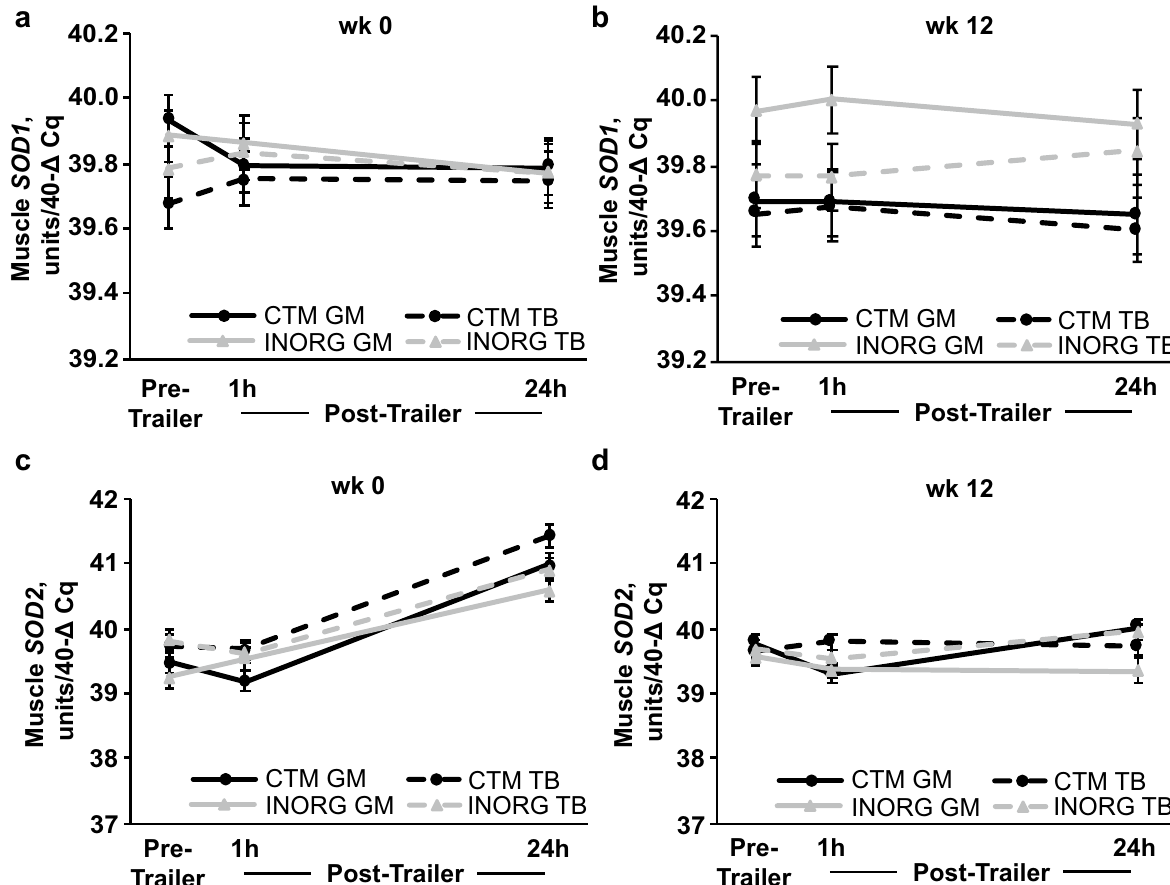
Figure 4. Gluteus medius (GM) and triceps brachii (TB) Cu–Zn superoxide dismutase ( SOD1 ; a , b ) and Mn superoxide dismutase ( SOD2 ; c , d ) expression before (pre-trailer), and 1 (1 h) and 24 h (24 h) after a 1.5-h trailer stressor. Trailer stressors occurred before (week 0; a , c ) and after (week 12; b , d ) 12 weeks of submaximal exercise training in yearling horses supplemented with either complexed trace minerals (CTM; n = 8) or inorganic trace minerals (INORG; n = 8). Overall effect of diet ( P = 0.468; P = 0.031; P = 0.907; P = 0.221), trailering ( P = 0.607; P = 0.922; P < 0.0001; P = 0.016), muscle group ( P = 0.138; P = 0.050; P = 0.003; P = 0.029), diet × trailering ( P = 0.932; P = 0.864; P = 0.569; P = 0.717), diet × muscle group ( P = 0.403; P = 0.189; P = 0.784; P = 0.052), trailering × muscle group ( P = 0.505; P = 0.881; P = 0.371; P = 0.113) and diet × trailering × muscle group ( P = 0.598; P = 0.782; P = 0.233; P = 0.006) for panels ( a – d) ,